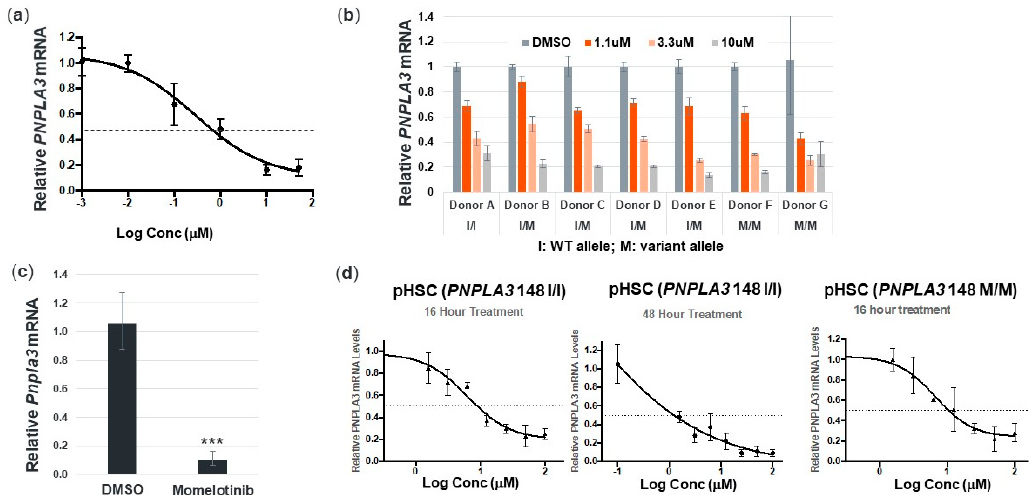
Figure 1. Momelotinib treatment reduces patatin-like phospholipase domain-containing 3 ( PNPLA3 ) expression dose dependently in human primary hepatocytes and stellate cells. ( a ) Dose–response curve for PNPLA3 mRNA in primary human hepatocytes (pHHs) after 16 h of treatment with momelotinib; ( b ) dose-dependent reduction of PNPLA3 mRNA in pHHs representing di ff erent PNPLA3 codon 148 genotypes. I: WT allele, M: variant allele; ( c ) Pnpla3 mRNA in mouse primary hepatocytes treated with 10 µ M momelotinib or DMSO control for 18 h; ( d ) dose response curve for PNPLA3 mRNA in WT primary human stellate cells (pHSCs) after 16 h and 48 h of treatment with momelotinib. First two panels are WT pHSCs, and the third panel is PNPLA3 148M / M pHSCs. All cell culture experiments were performed in triplicate, and the bars represent the mean of triplicate experiments. Error bars represent the SD of the triplicates. An unpaired t -test was used for panel ( c ), where p <